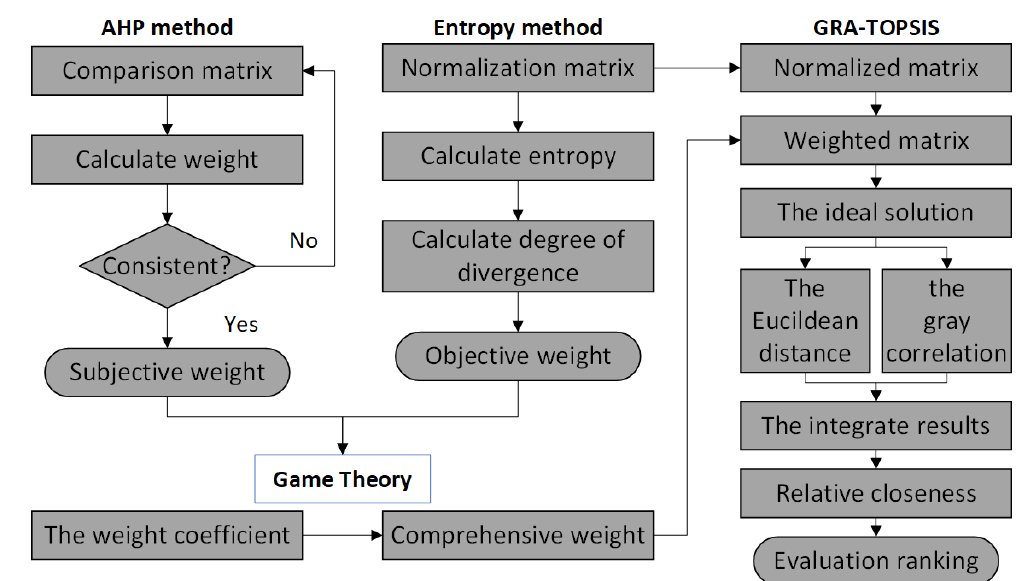
Figure 1. GRA-TOPSIS method flow